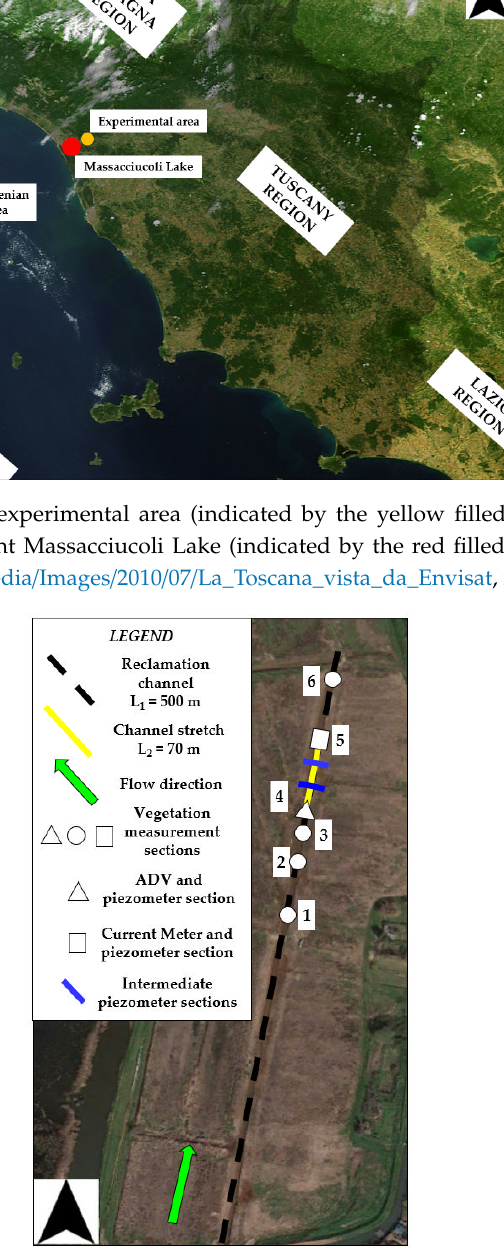
Figure 2. Surveyed cross sections (1–6) along the 500-m long vegetated reclamation channel, indicated by the black dashed line. The 70-m long experimental channel stretch is indicated by the yellow continuous line. The white filled circles indicate the measuring sections employed for the measurements of the vegetative morphometrical properties, while the white filled triangle and square represent the ADV and current meter measuring cross section, which coincides with the upstream cross section of the 70 m long experimental channel stretch, also employed for the water tables measurements. The blue continues lines indicate the other two intermediate water level measuring cross sections. (From Lama et al. [3], modified).